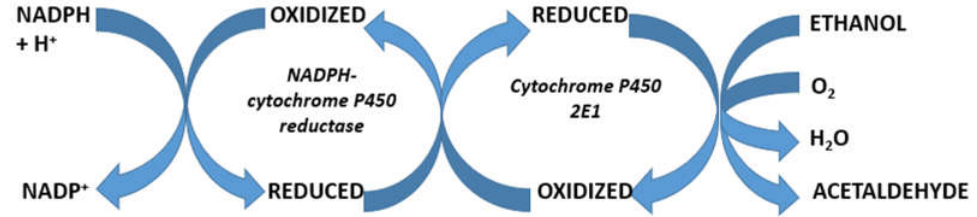
Figure 3. Constituents of MEOS. A key role is attributed to the hepatic microsomal cytochrome P450 2E1, but NADPH-cytochrome P450 reductase plays also an obligatory role; the metabolic reaction of MEOS requires phospholipids, the site of their reaction is unknown. Reproduced from a previous report [25], with permission of the Publisher Taylor & Francis (Didcot, UK).